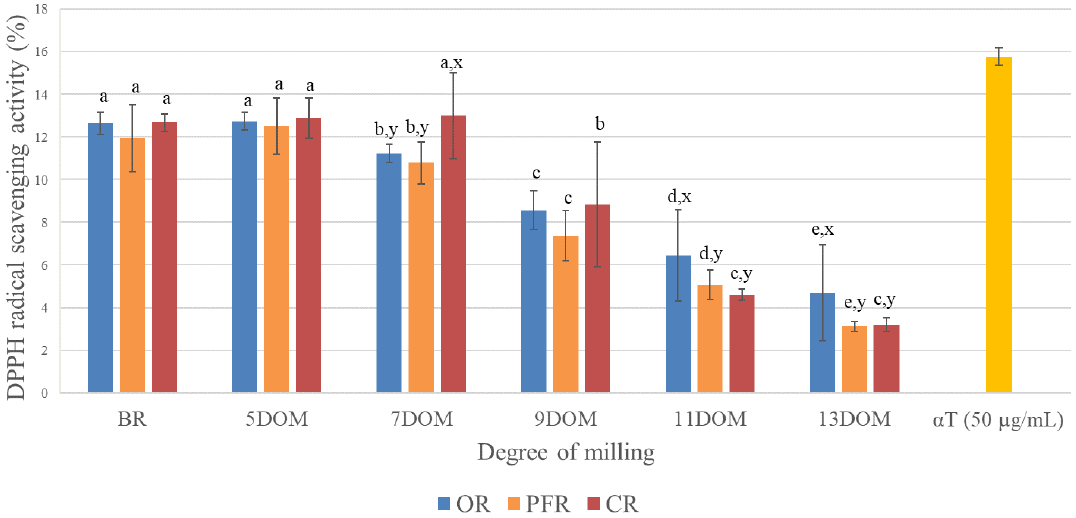
Figure 7. DPPH-free radical scavenging activity by rice type depending on the degree of milling. Different superscripts represent a significant difference depending on the DOM (a–e, p < 0.05) and rice type (x and y, p <